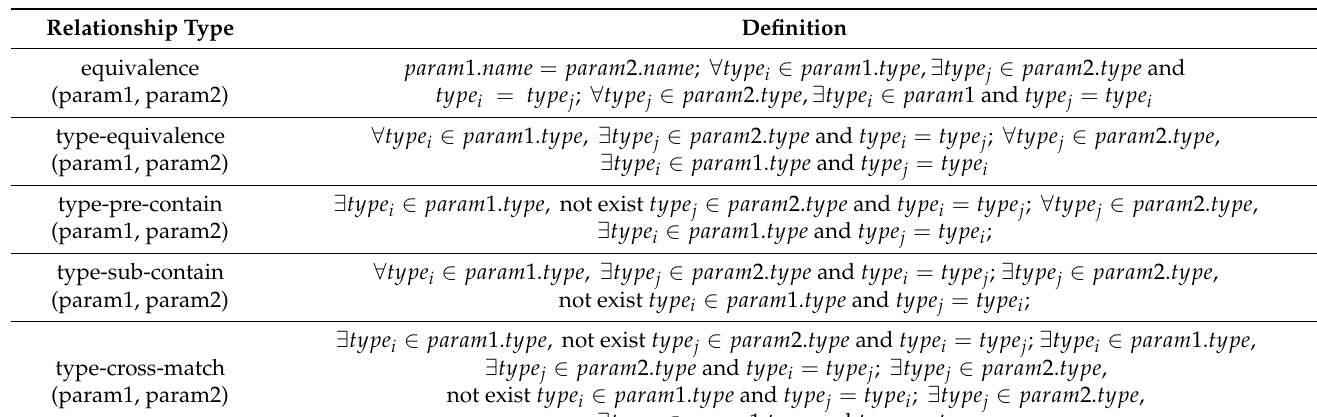
Table 1. Parameter-level relationship